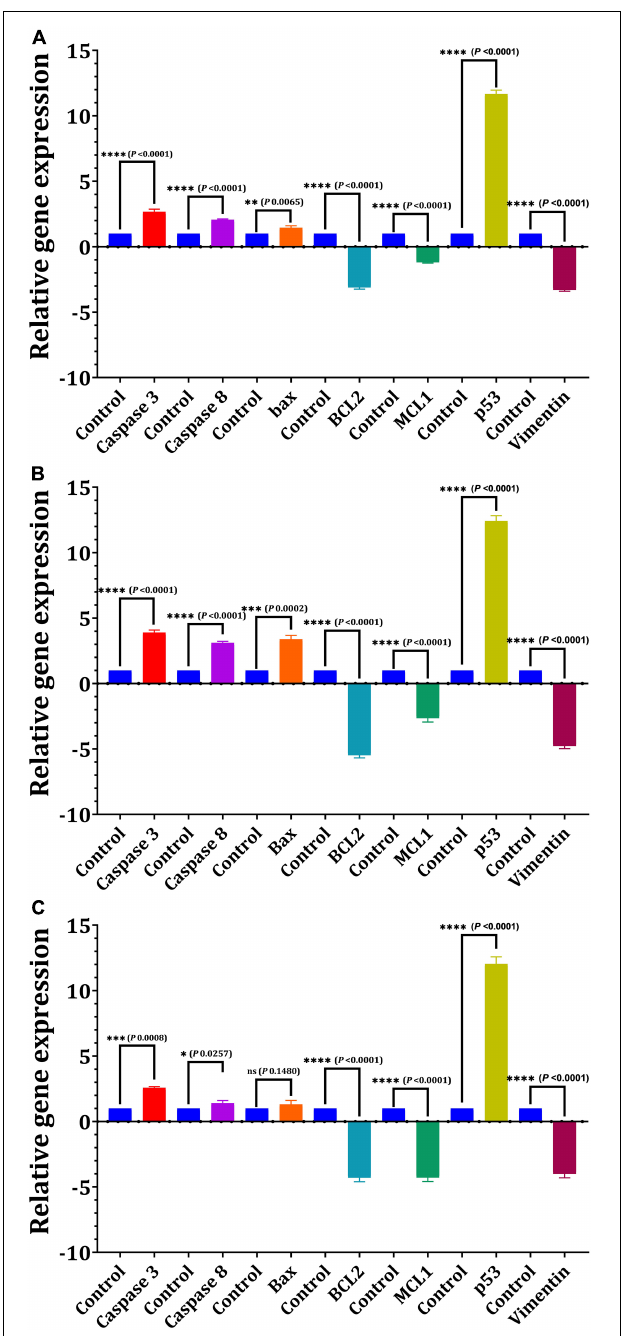
Figure 7 | Effect of L. delbrueckii subsp. bulgaricus DSM 20081 T -EPS 5 on the relative expression of genes linked to apoptosis in different cell lines. (A) MCF7, (B) CaCo2, (C) HepG2.